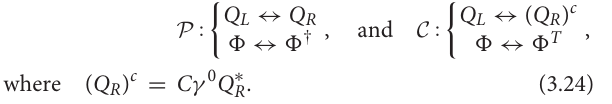
FIGURE 4 | Branching fractions of process N i lightest neutrino mass for NH and IH in the case (cid:127) m h 125 GeV, assuming vanishing Majorana =